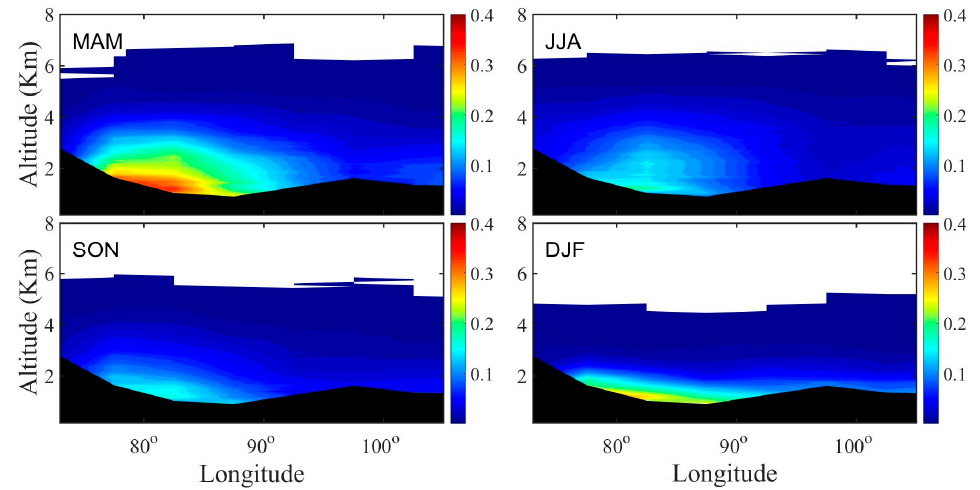
Figure 7. Seasonal cross sections of total dust extinction coefficients (km − 1 ) along a latitude of 40 ◦ N and longitudinal range of 73 ◦ E to 105 ◦ E based on CALIPSO data.